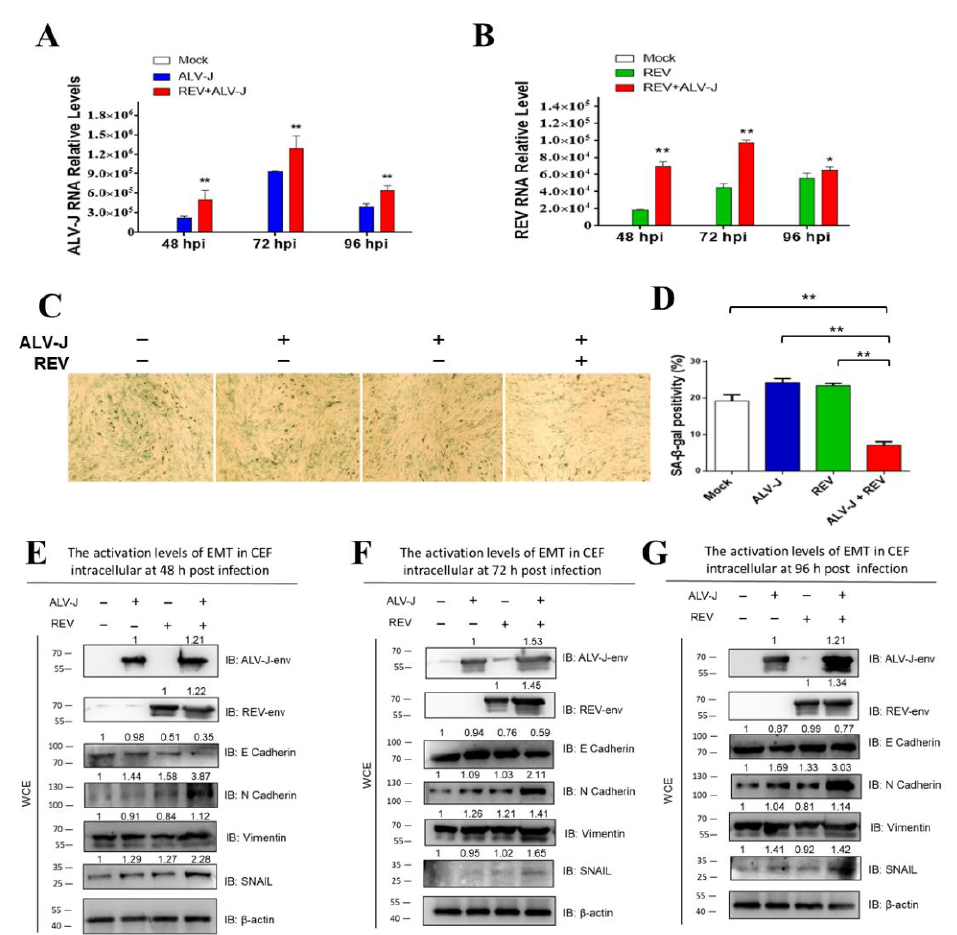
Figure 1. ALV-J and REV synergistically suppress cellular senescence and activate EMT in vitro. ( A , B ) ALV-J and REV synergistically promoted mutual replication in chicken embryo fibroblast (CEF) cells at 48 hpi, 72 hpi, and 96 hpi. The data are presented as mean ± SEM, and were obtained from three independent experiments ( n = 3); each experiment contained triplicates. ( C ) ALV-J and REV synergistically inhibited CEF cellular senescence. CEFs were infected with either ALV-J, REV, or both, and examined via senescence-associated (SA) β -Gal staining on day 6 pi (100 × ). ( D ) Quantification of results shown in ( C ). ALV-J and REV synergistically activated EMT in CEF cells at 48 hpi ( E ), 72 hpi ( F ), and 96 hpi ( G ). ALV-J and REV synergistically enhanced N-cadherin, vimentin, and SNAIL protein levels, and synergistically decreased the E-cadherin protein level in CEF cells at 48 hpi, 72 hpi, and 96 hpi, as detected using WB. ** p ≤ 0.01 determined using Student (cid:48) s t -test versus the Neg. Ctrl. group. * p ≤ 0.05 determined using Student (cid:48) s t -test versus the Neg. Ctrl.